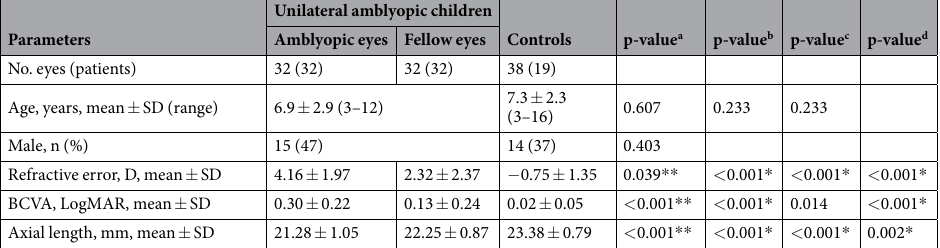
Table 1. Comparison of demographic and clinical parameters between groups. SD: standard deviation; D: diopter; BCVA: best-corrected visual acuity; logMAR: minimal angle of logarithm. a Kruskal Wallis test between Amblyopic eyes, fellow eyes, and controls. b Mann-Whitney test between amblyopic eyes and controls. c Mann- Whitney test between fellow eyes and controls. d Mann-Whitney test between amblyopic eyes and fellow eyes. * Statistically significant p-value.